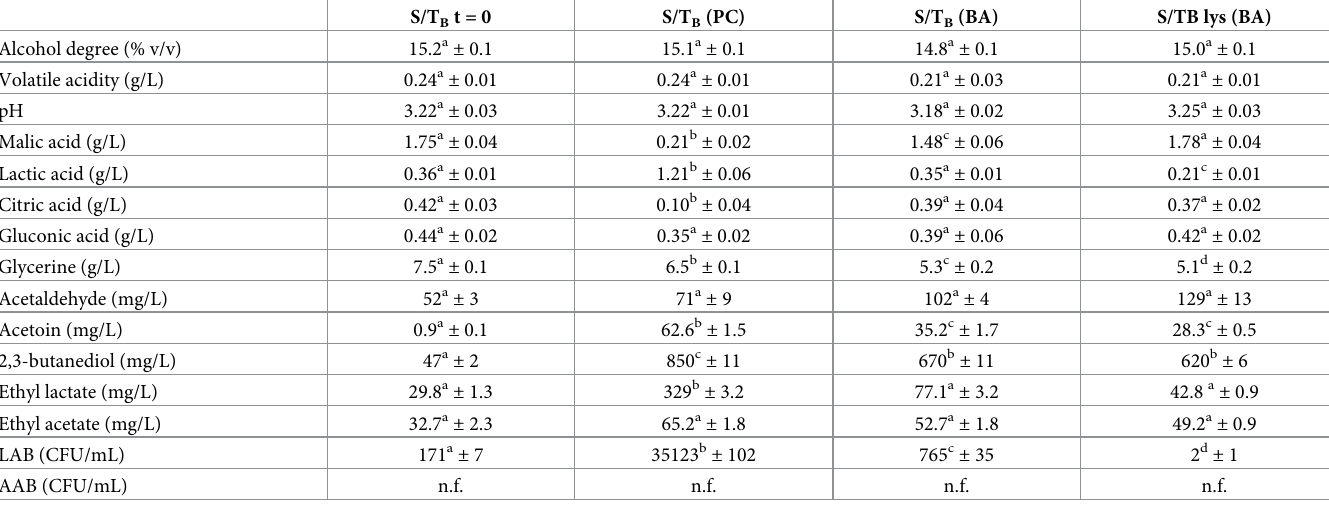
Table 4. Evolution of analytical composition of the S/T B "sobretablas" casks sets classified as PC and BA after 1 year of aging.